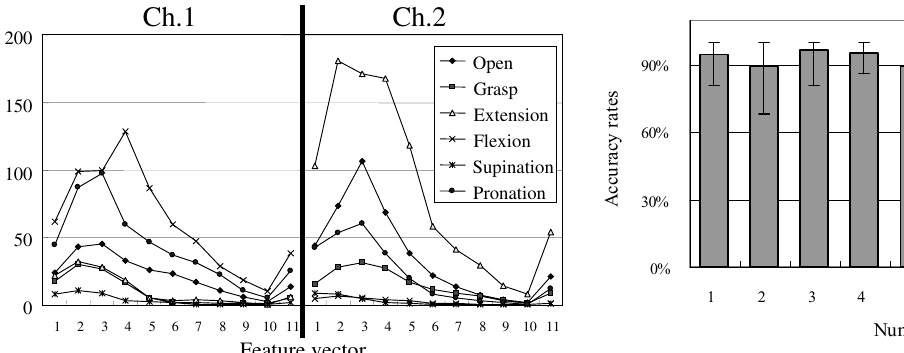
Figure 7 Recognition results for 10 trials. Each bar represents the average value over 7 gestures recognised and their deviations.